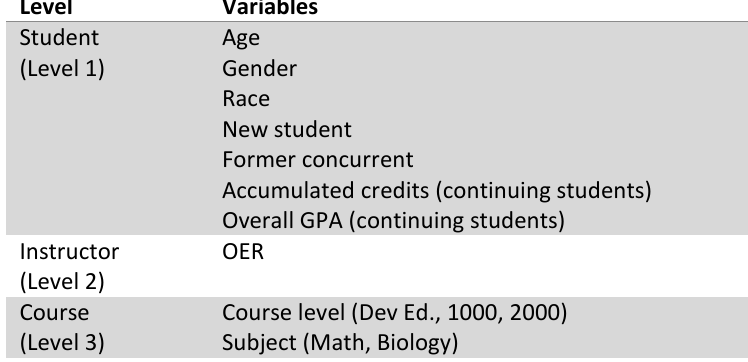
Figure 3. Independent variables included in